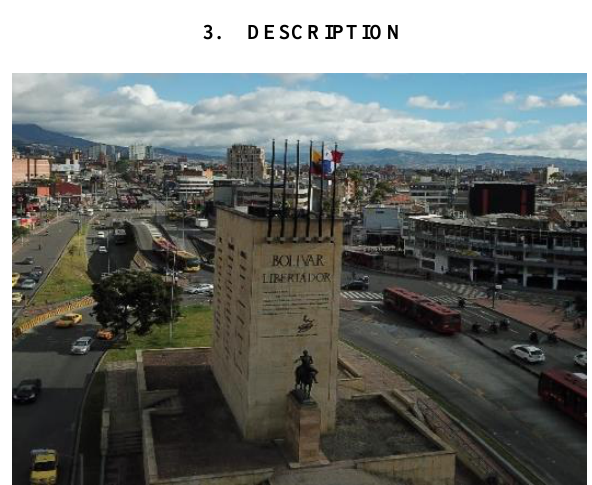
Figure 1: Monument to Heroes. IDPC source.